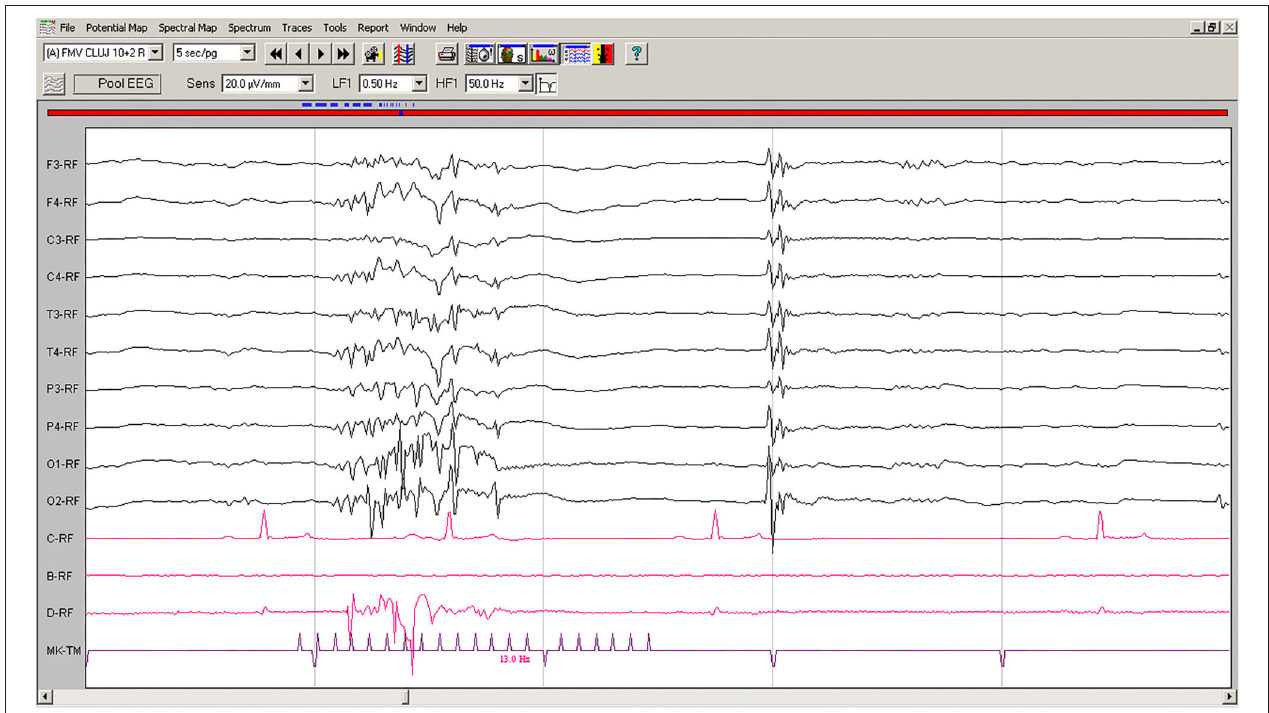
FIGURE 2 | IPS-induced EEG recording of Case No. 1 patient (8-year old male Beagle): IPS at 13Hz generates polyspikes-slow wave complexes visible on all derivations, accompanied by sudden generalized myoclonic contractions. Low-cut filter: 0.5Hz; high-cut filter: 50Hz; speed 5 s/page; channel C: ECG, bipolar on the chest; channel B: empty; channel D: bipolar, right brachiocephalic muscle; MKT channel: photic stimulation marker. Figure shown at 20 µ V/mm. IPS, intermittent photic stimulation; EEG, electroencephalogram; ECG, electrocardiography.